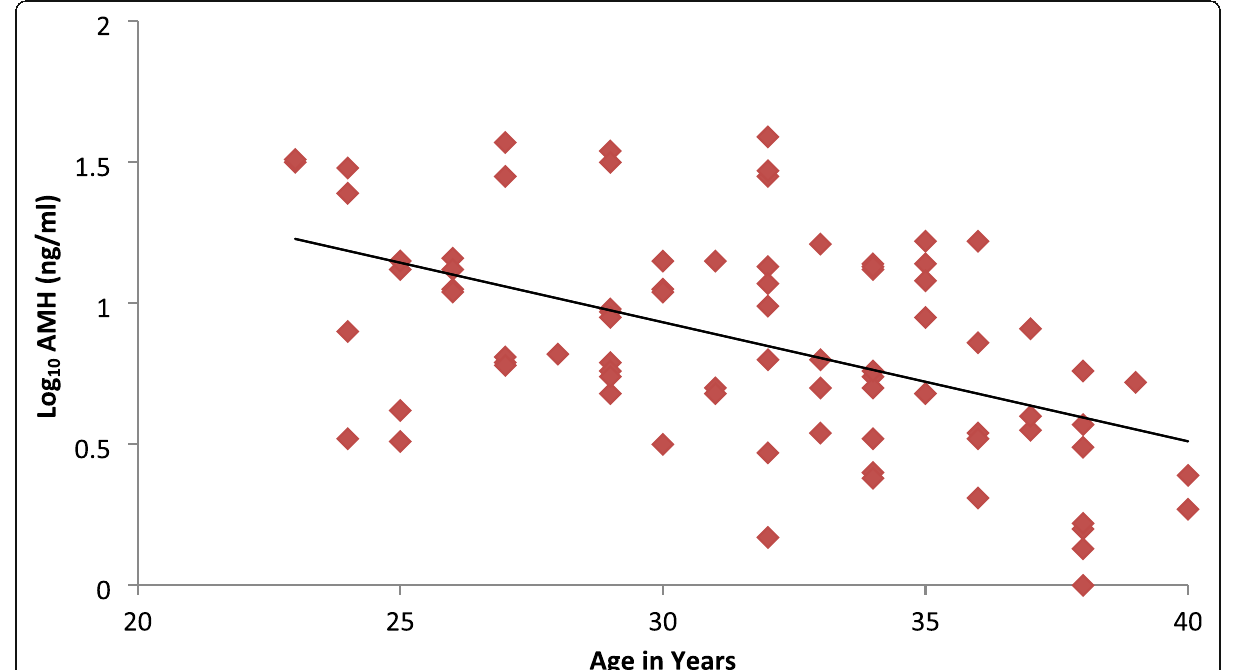
Fig. 1 Scatterplot of Log 10 AMH (ng/mL) by Age in Years in Infertile